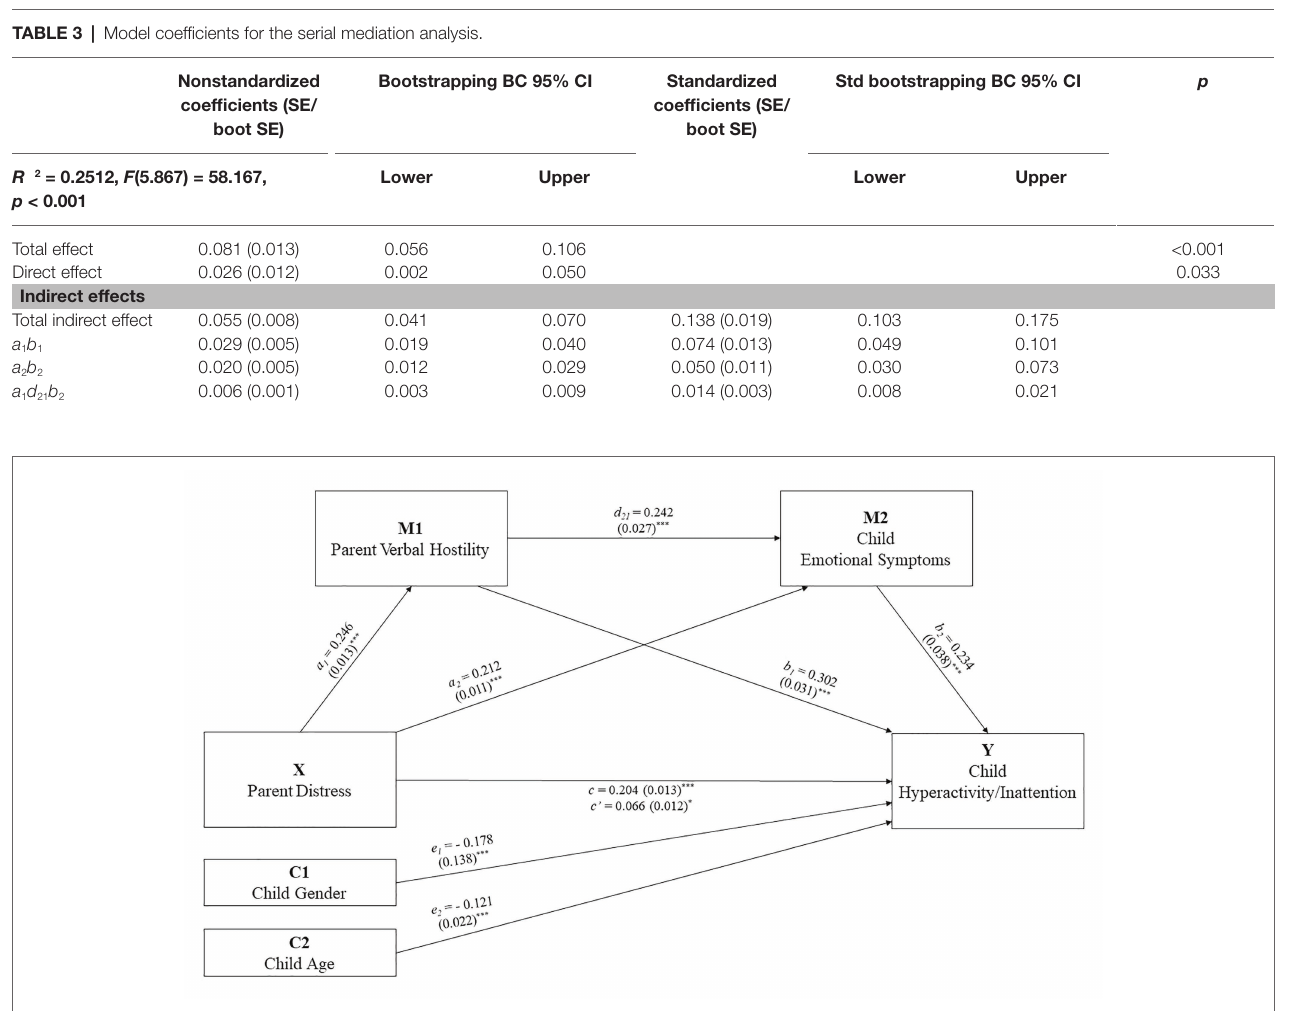
TABLE 3 | Model coefficients for the serial mediation analysis.